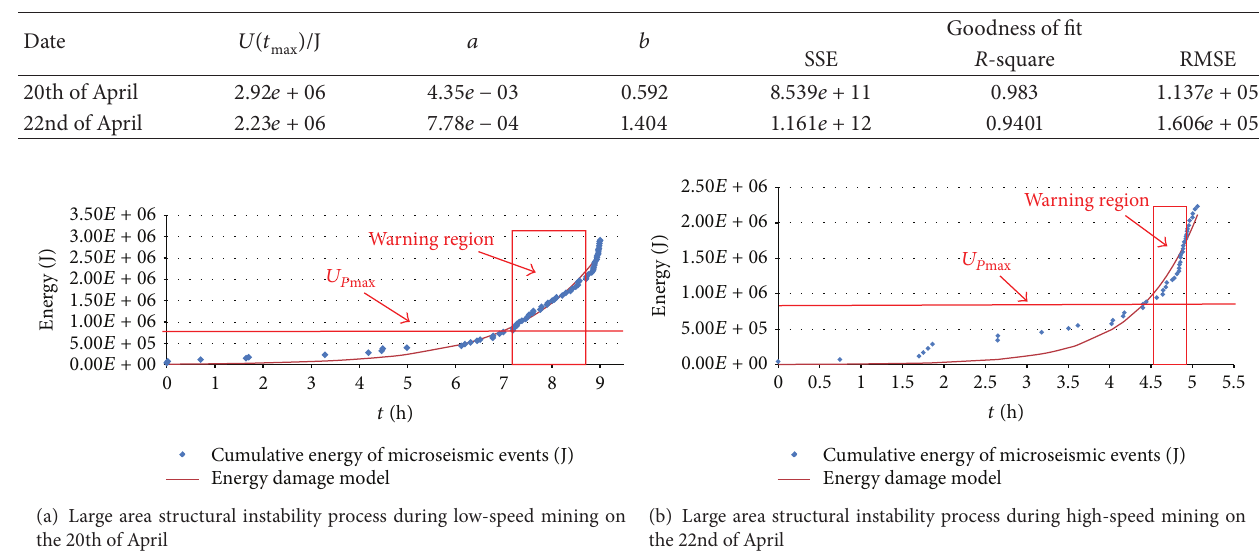
Figure 8: Energy damage process comparisons between low-speed mining and high-speed